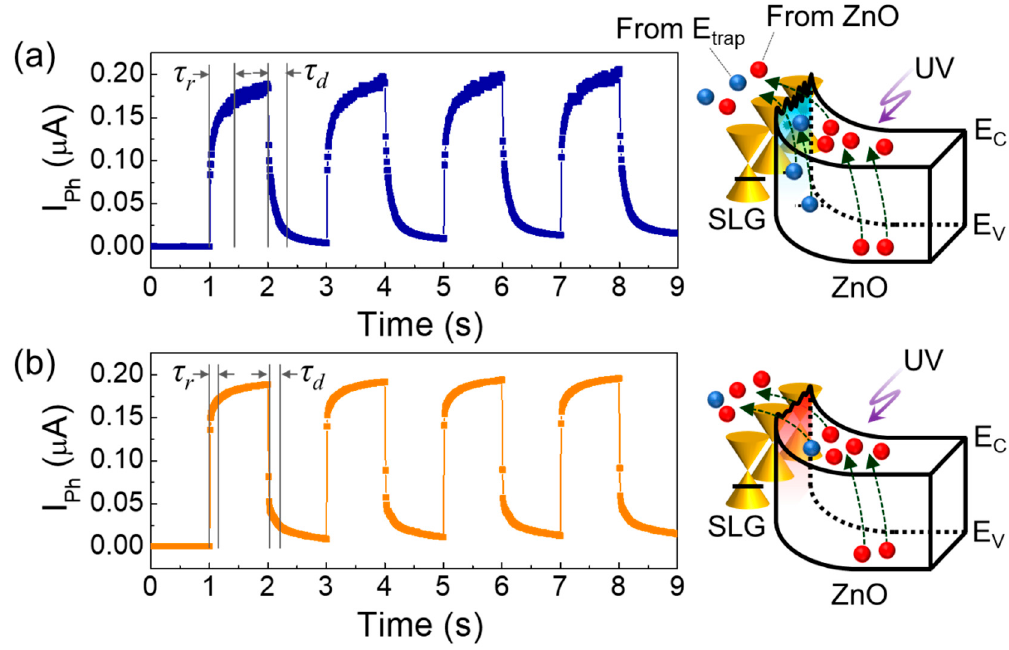
Figure 8. Photoresponse transient characteristics for the ( a ) ZnO / AT-SLG and the ( b ) ZnO / TC-SLG Schottky PDs under UV light illumination with P UV = 0.77 mW / cm 2 . τ r and τ d were determined when the photoresponse had leached 90% and 10% of the on-state current time, respectively. The right-hand-side insets display the contribution of various photogenerated carriers to I Ph under UV light illumination (blue dots: photocarriers from defect sites at the interface between ZnO / SLG, red dots: photocarriers from ZnO). Table 1. Comparison of the photoresponse characteristics for various types of graphene/ZnO-based Schottky PDs.